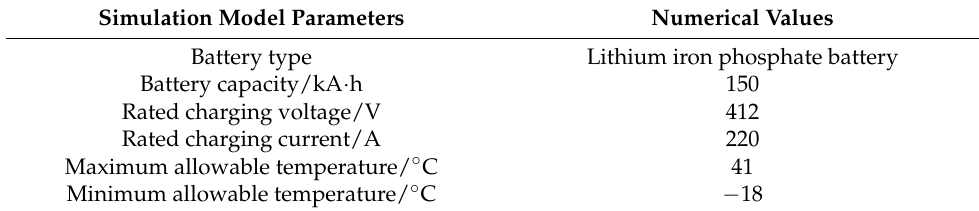
Table 5. Parameters of simulated electric